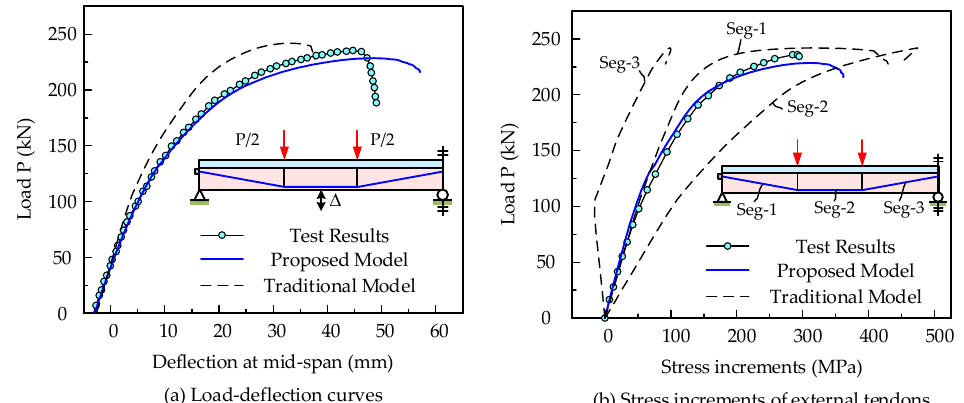
Figure 16. Analysis results of specimens PCCB-4.